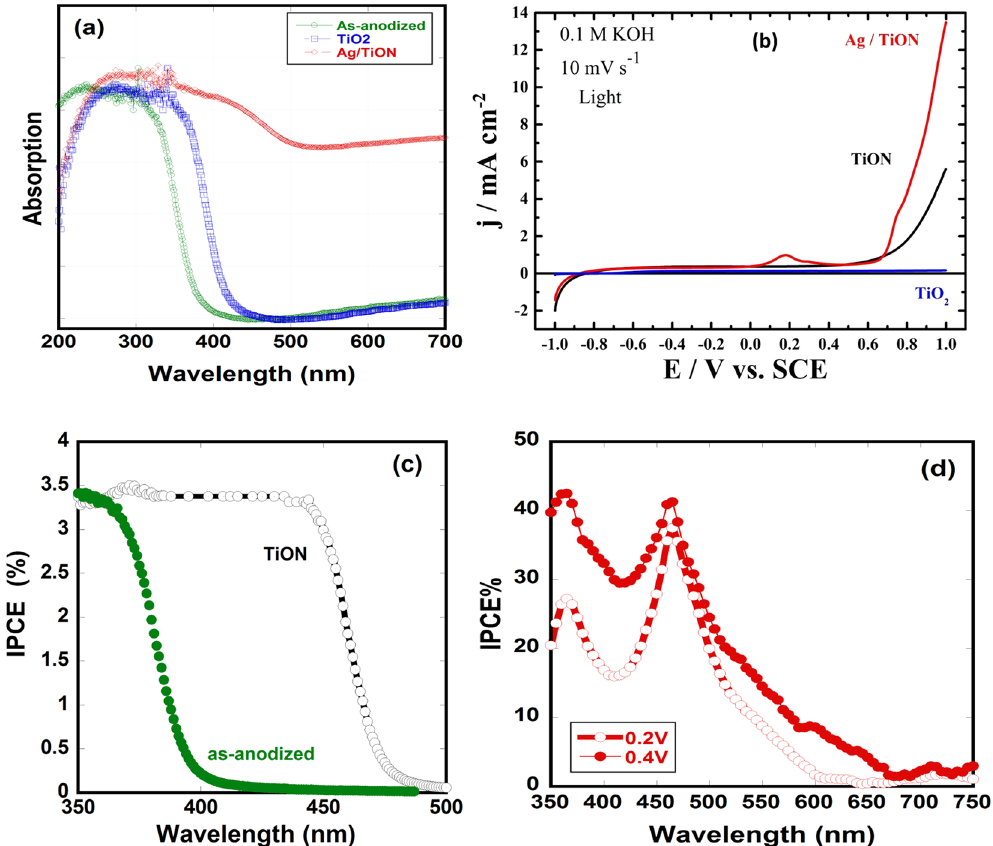
Figure 4. ( a ) UV-Vis absorption spectra of as-anodized nanotubes, TiO 2 nanotubes annealed in air and Ag- decorated TiON nanotubes(Ag/TiON), ( b ) linear sweep voltammetry under illumination of TiO 2 , TiON and Ag/TiON, ( c ) the IPCE under no bias of as-anodized and TiON samples, and ( d ) the IPCE of Ag/TiON under applied